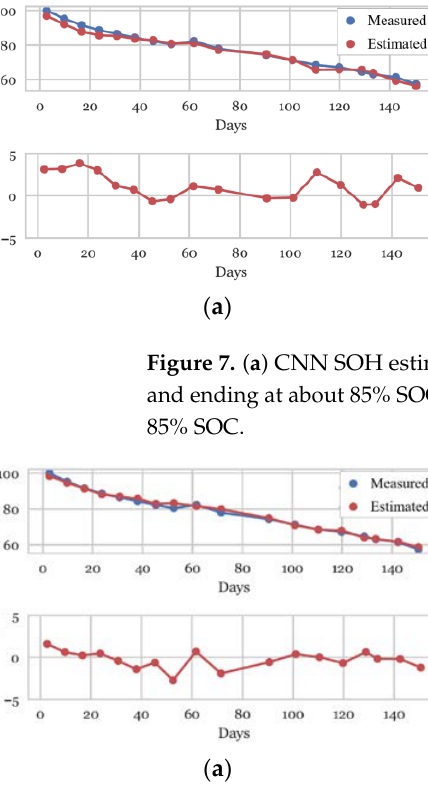
Figure 8. ( a ) CNN SOH estimation and error for partial charge curve input beginning at 60% SOC and ending at about 92% SOC. ( b ) Partial charge profiles beginning at 60% SOC and ending at about 92% SOC.